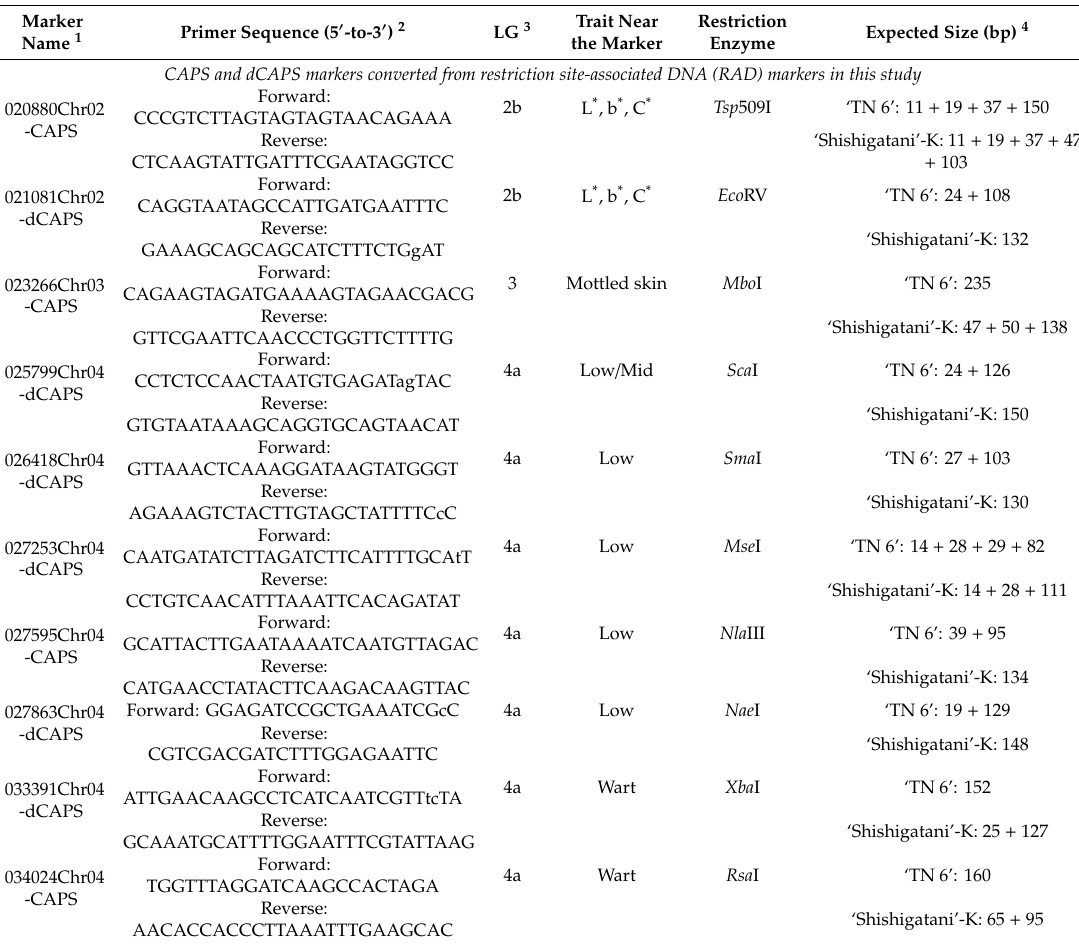
Table 3. List of codominant cleaved amplified polymorphic sequence (CAPS) and derived CAPS (dCAPS) markers developed and modified in this